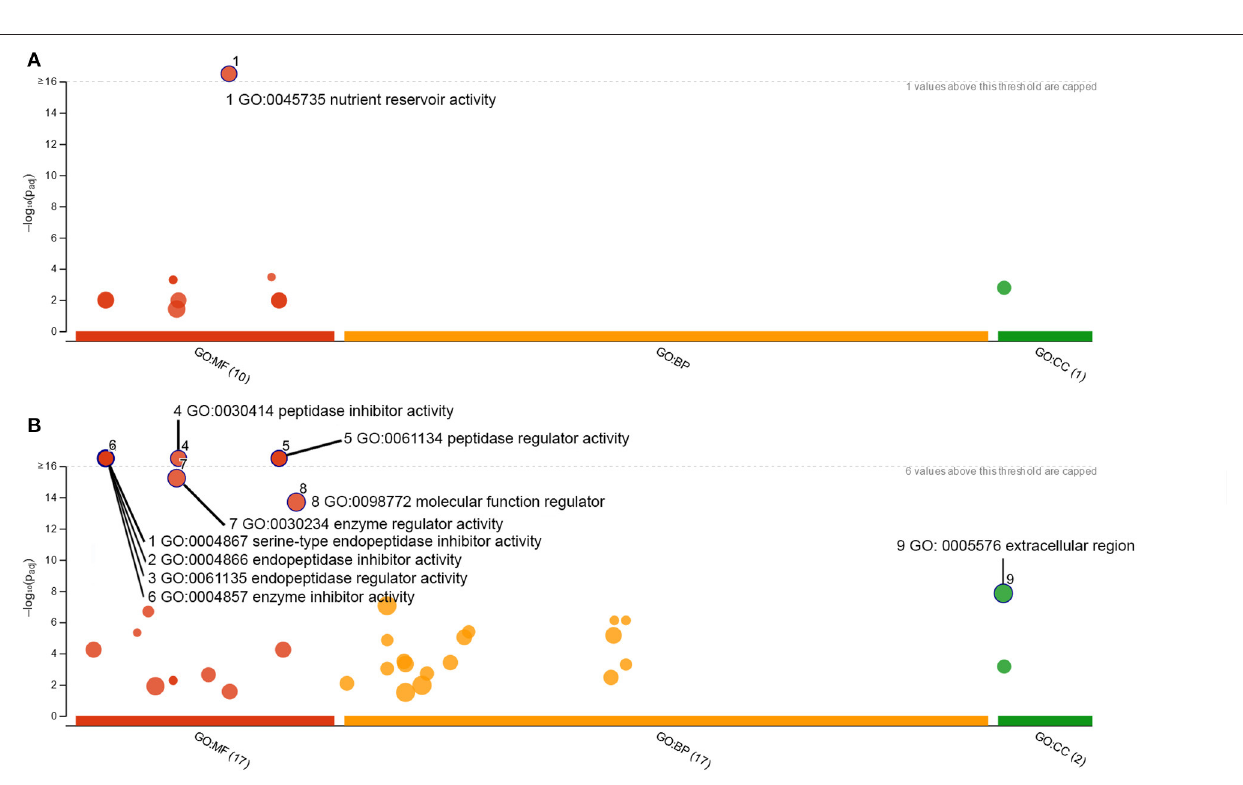
FIGURE 4 | GO enrichment analysis of proteins showing ≥ 2-fold increase in: MW (A) ; or GW (B)